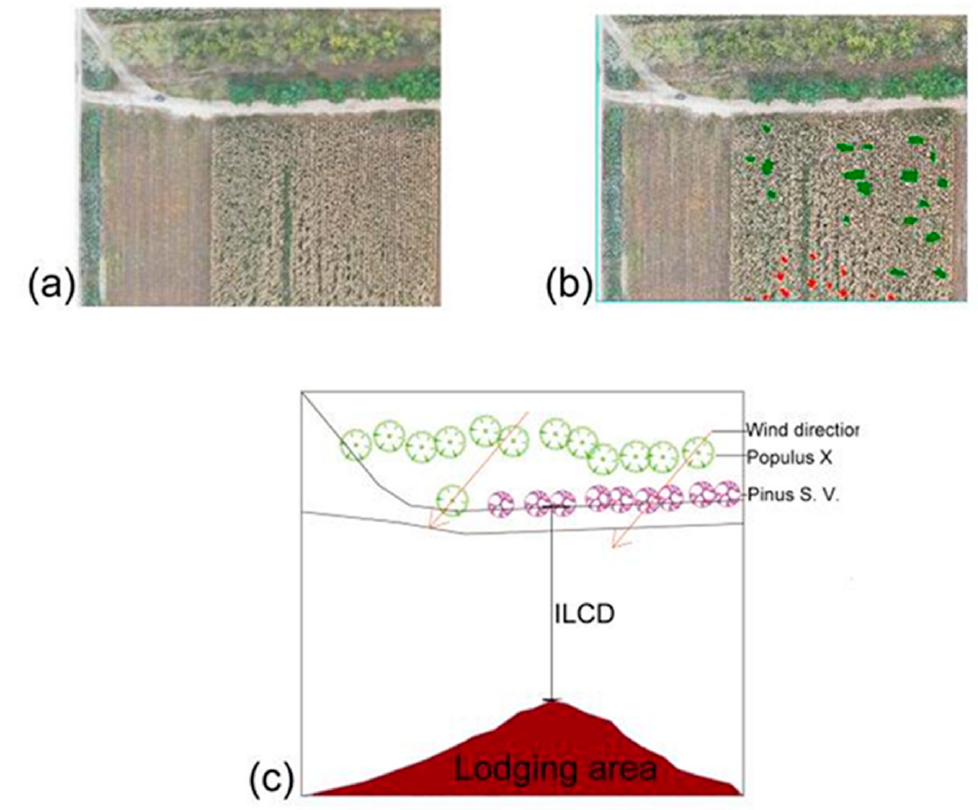
Figure 4. Extraction steps and drawing: ( a ) corrected imagery; ( b ) unlodged crops are shown in green and lodged crops are shown in red; ( c ) red is the crop lodging area. F is the starting lodging distance of the crops behind the shelterbelt.